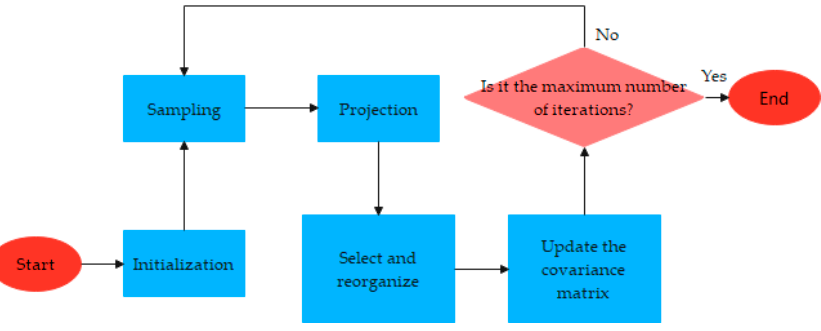
Figure 8. Optimization process flow chart.